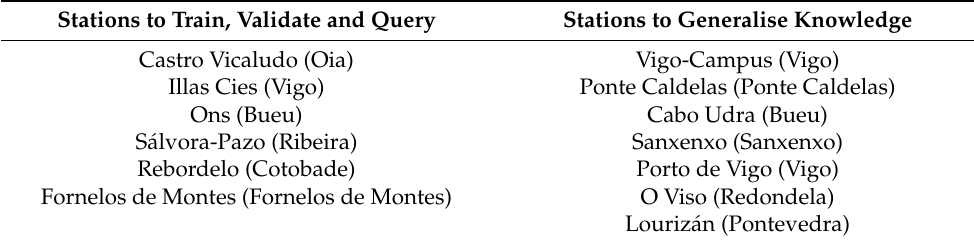
Table 1. Measurement stations used in this research. The six stations on the left correspond to the stations used to train, validate and query the different models. The seven stations on the right correspond to the stations used to study the generalisation of the best selected models. Stations to Train, Validate and